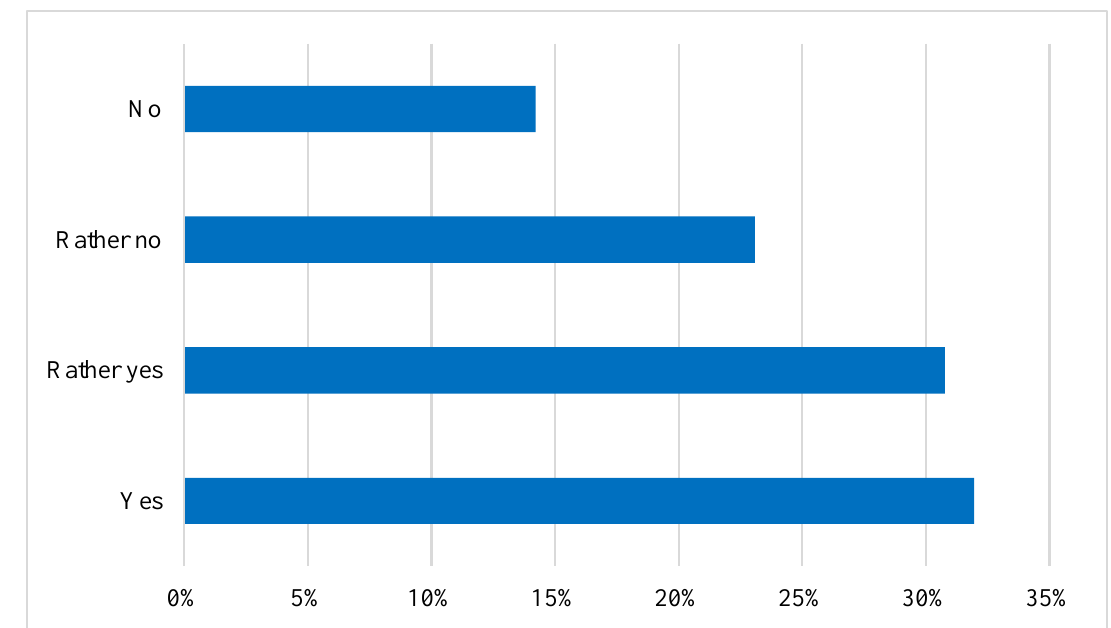
Figure 9. The importance of the origin of the purchased carp. Source: own elaboration based on data of [43].